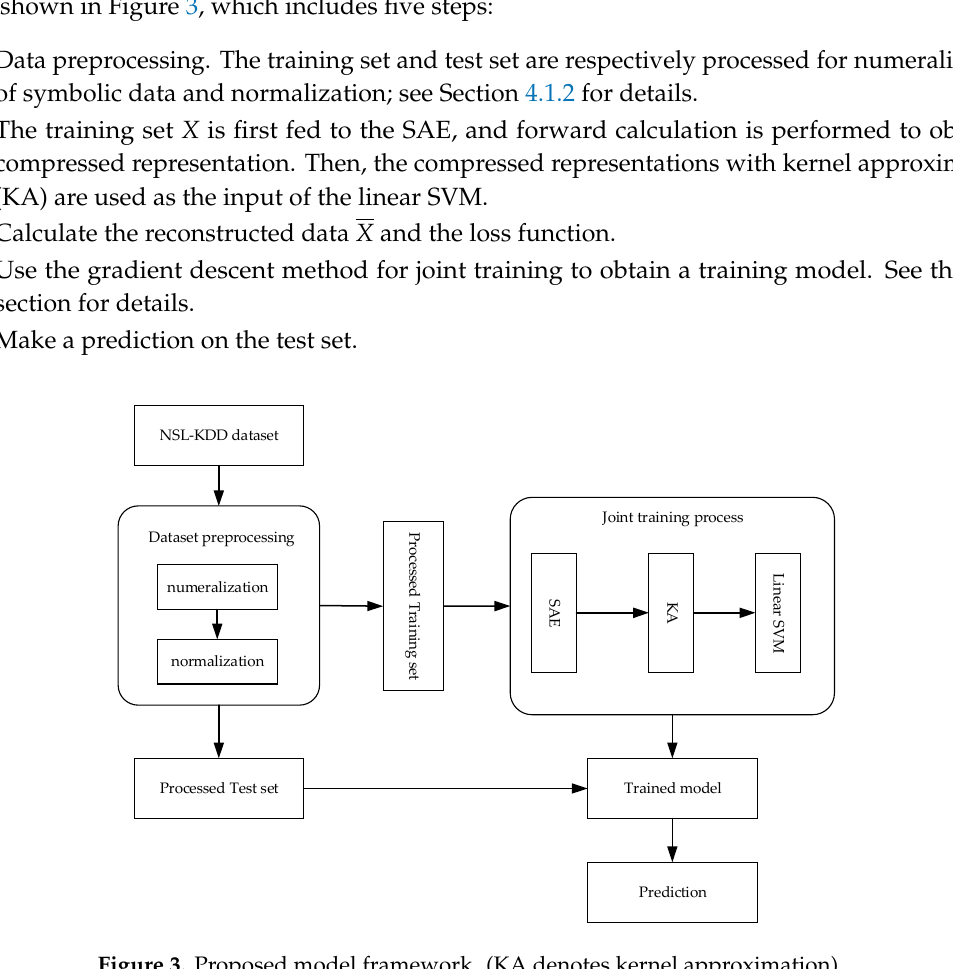
Figure 3. Proposed model framework. (KA denotes kernel approximation)